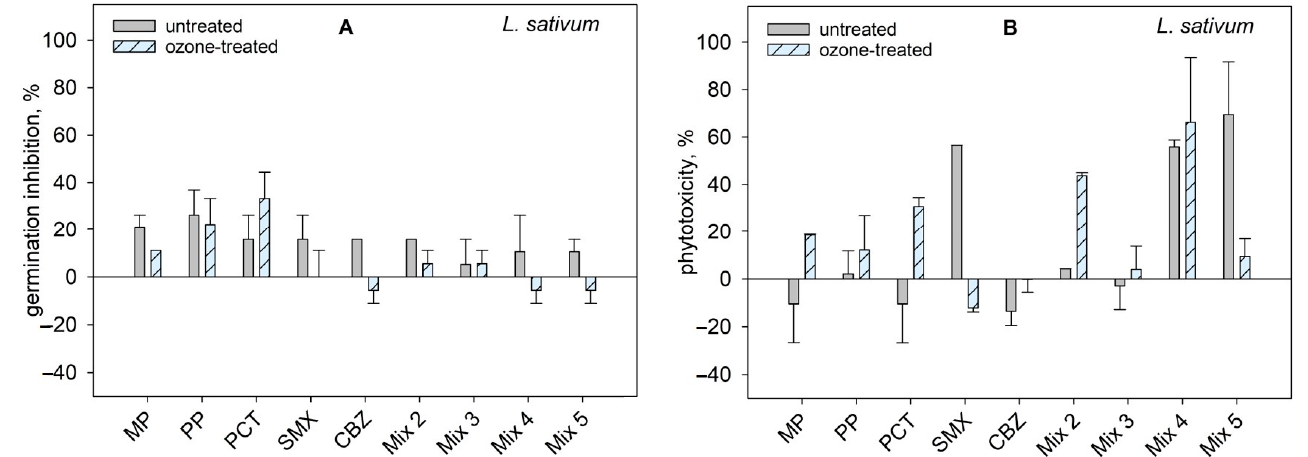
Figure 6. The toxicological response of Lepidium sativum after 48 h of exposure to untreated and ozone-treated solutions: the germination inhibition ( A ) and the percentage of phytotoxicity ( B ). The bars represent the mean, and the error bars represent the standard error of the mean. Mix 2: MP+PP; Mix 3: MP+PP+PCT; Mix 4: MP+PP+PCT+SMX; Mix 5: MP+PP+PCT+SMX+CBZ.